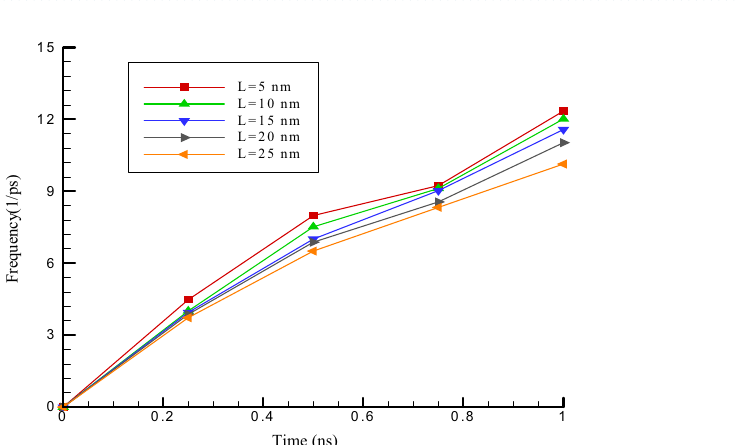
Figure 6. Oscillation frequency changes of carbon nanotubes versus length of carbon nanotubes (7 and 7) in different time steps.